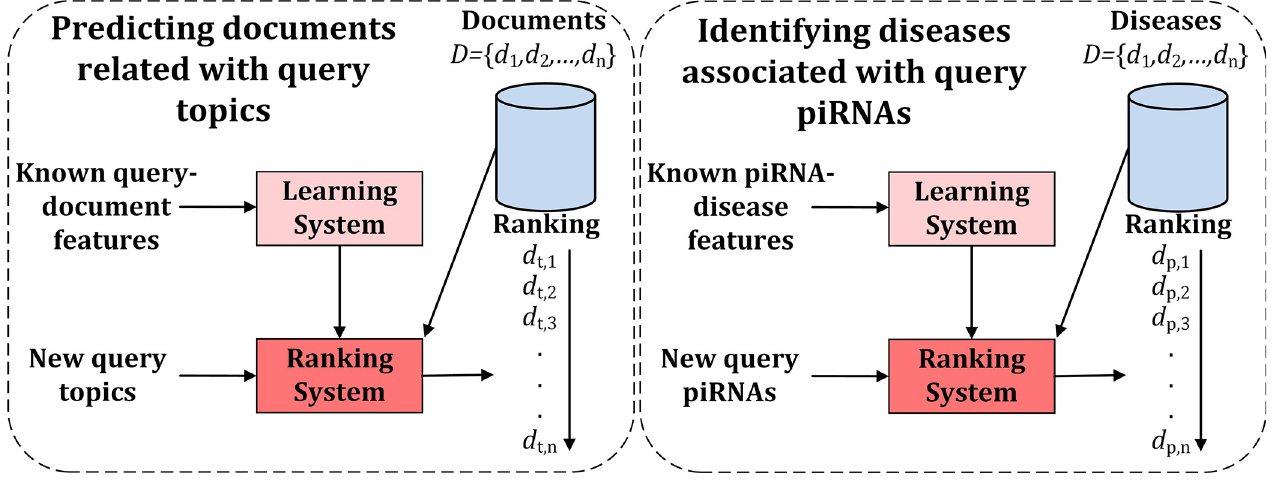
Fig 1. The similarities between the prediction of documents related with query topics and the identification of diseases associated with query piRNAs, where piRNA and disease can be treated as query and document, respectively.